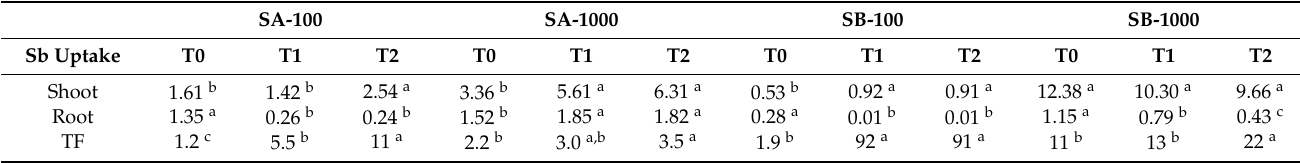
Table 3. Sb uptake, and translocation factor (TF Sb ), by triticale plants grown in amended and unamended Sb-polluted SA and SB soils. Average values are reported. T0, T1 and T2 refer to MSWC addition, i.e., 0, 1 and 2%, respectively. For each soil (SA and SB) and Sb concentration level, different letters (a, b and c) denote significant differences between treatments (Tukey–Kramer test; p <